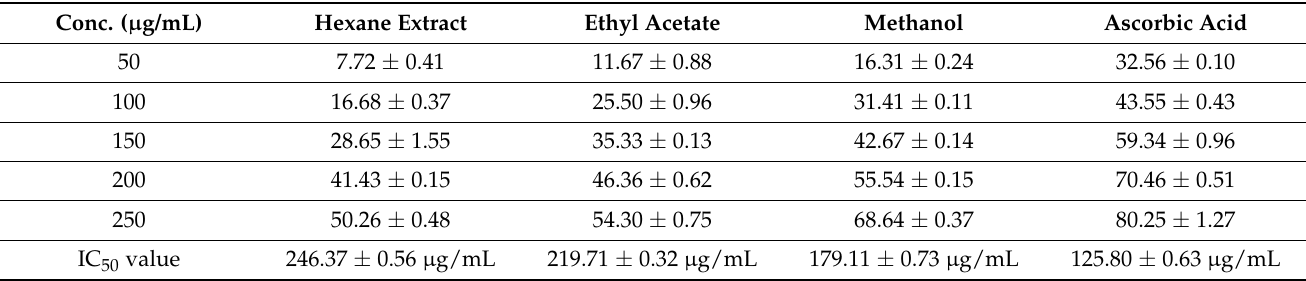
Table 4. Ferric-reducing antioxidant power (FRAP) values for A. chasmanthum rhizomes.